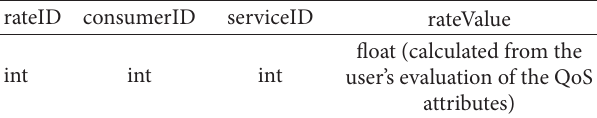
Algorithm 1: Trading between buyers and sellers. Table 3: Quality of service (QoS) parameters for cloud